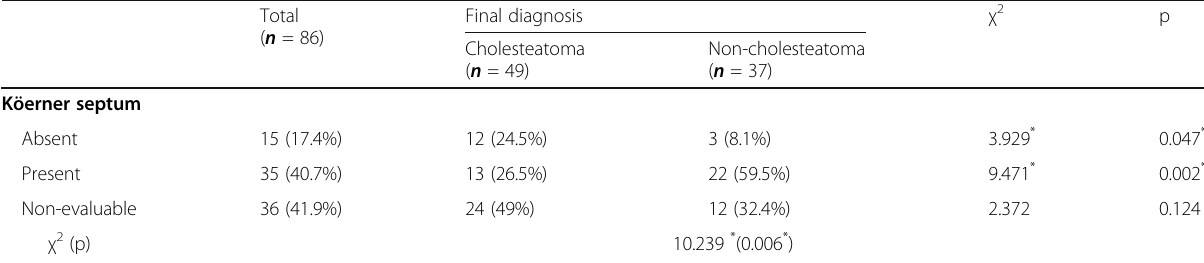
χ 2 : Chi square p: p value for comparing between Cholesteatoma and Non-cholesteatoma *: Statistically significant at p ≤